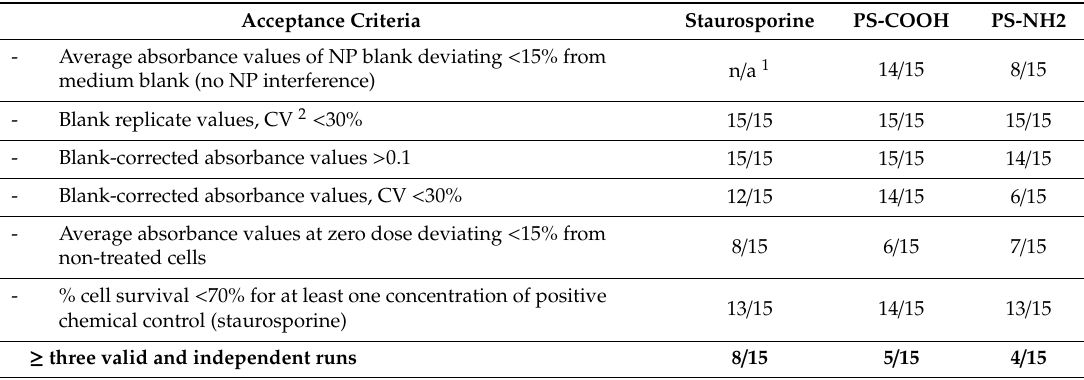
Table 1. Compliance of laboratories with the acceptance criteria of the 3-(4,5-dimethylthiazol-2-yl)-5- (3-carboxymethoxyphenyl)-2-(4-sulfophenyl)-2H-tetrazolium (MTS) cytotoxicity assay. The number of compliant laboratories compared to the total number of laboratories is indicated per test